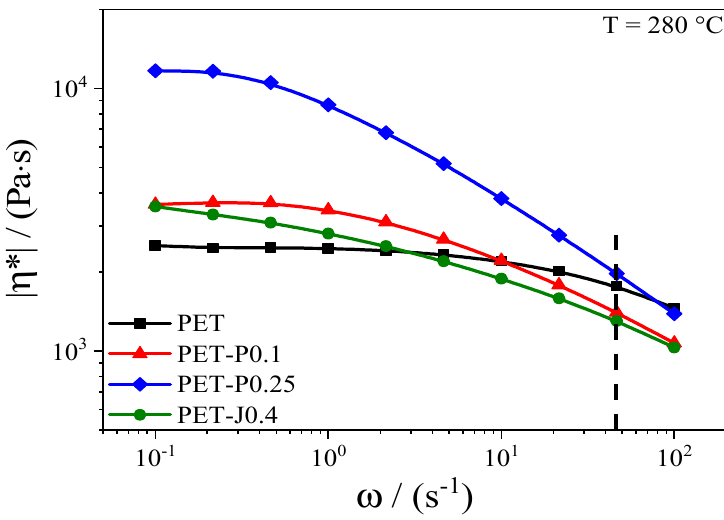
Figure 3. Magnitude of complex shear viscosity as a function of angular frequency for PET modified with PMDA or Joncryl. The vertical line represents the shear rate in the extruder during the film blowing experiments.